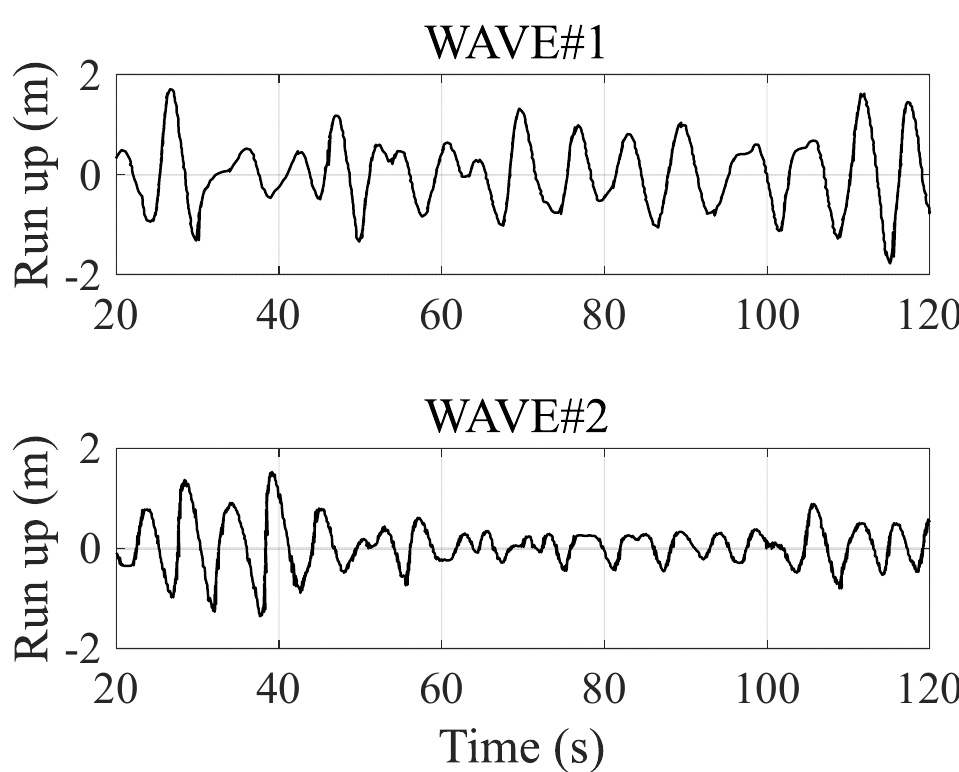
Figure 9. Wave run-up time series of irregular Wave#1 and Wave#2 .